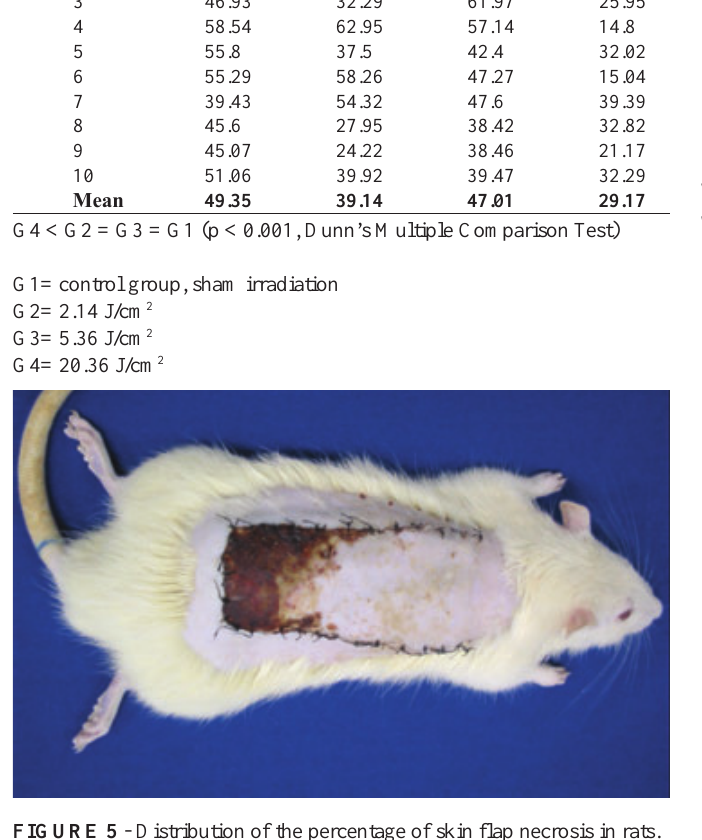
FIGURE 5 - Distribution of the percentage of skin flap necrosis in rats.